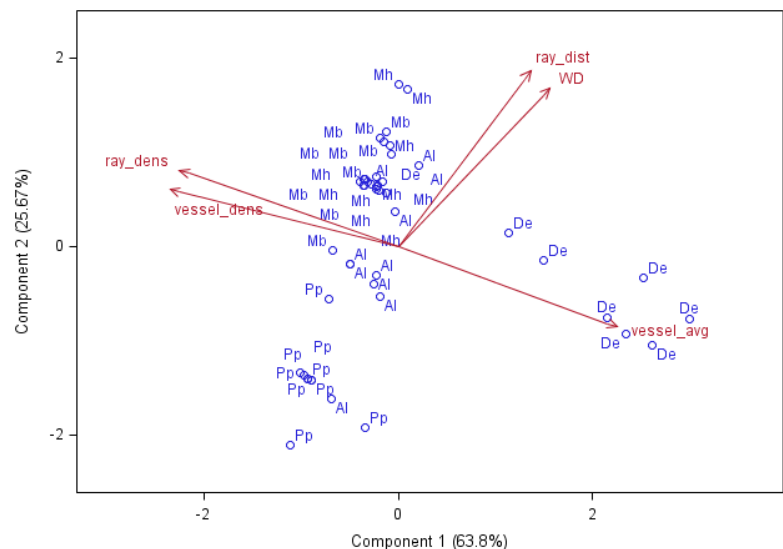
Figure 2. Principal components analysis of wood anatomical characteristics for D. excelsa (De; N = 8), P. psilostachya , M. elata , M. bidentata , and A. lecointei (respectively Pp, Mh, Mb, and Al; N = 10). Variables considered were number of vessels / mm 2 (vessel_dens), number of rays / mm 2 (ray_dens), average distance between rays (ray_dist), average vessel maximum lumen diameter (vessel_avg), and wood density (WD). Values in parenthesis correspond to the variance (%) explained by each principal component.